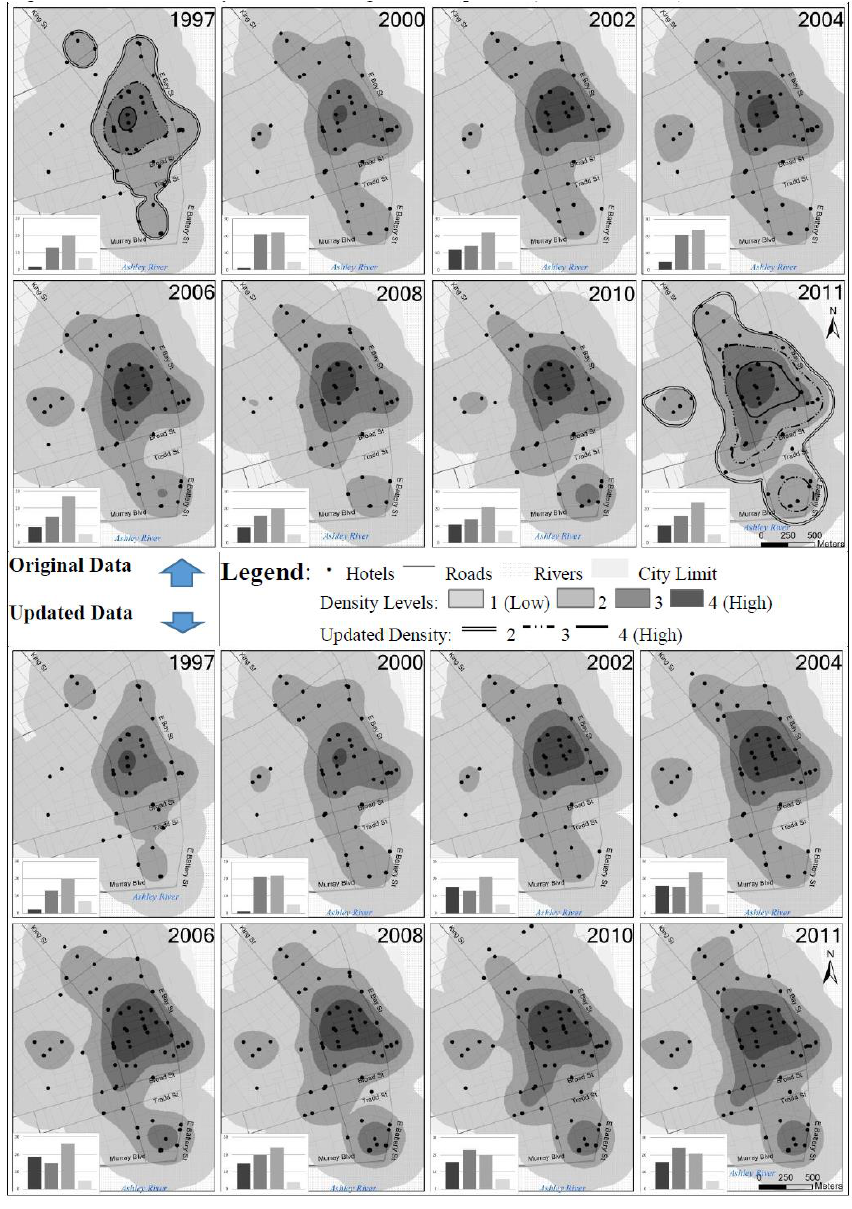
Figure 4. Kernel density of hotels: Original vs. updated (Charleston, NC, USA).